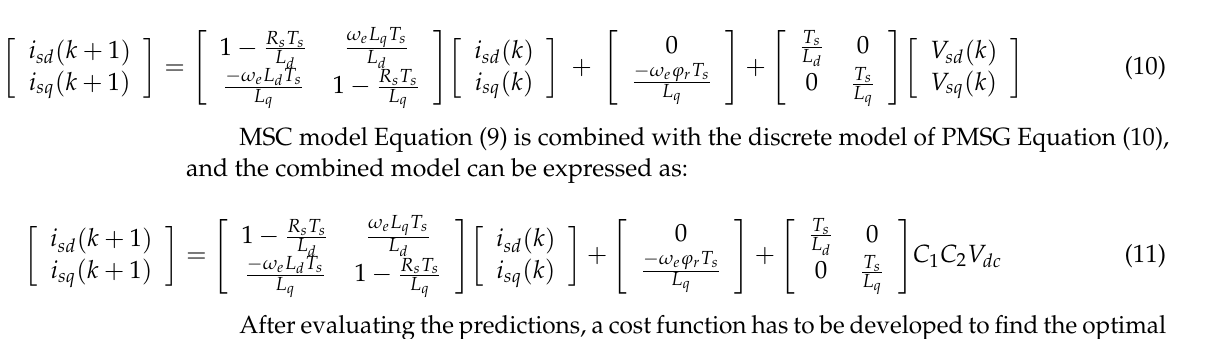
Figure 3. Traditional schematic diagram of finite control set-model predictive controller (FCS-MPC) system. The FCS-MPC uses the concept of discrete-time model to predict current values at a future sampling period. For discretization, the well-known forward Euler method with sampling time T s is applied to the time-continuous model Equations (2) and